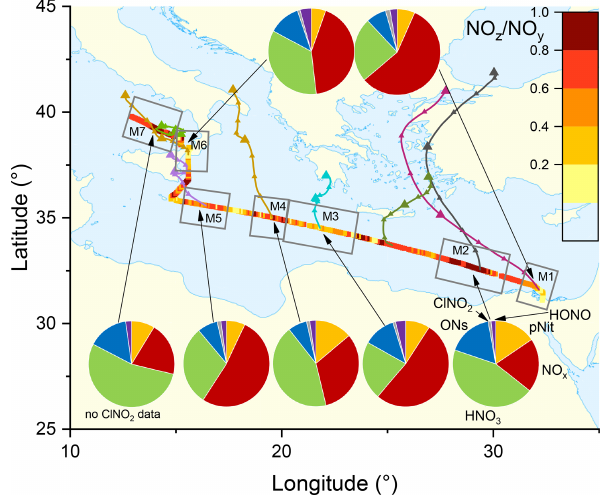
Figure 3. The NO z / NO y ratio over the Mediterranean Sea . Coloured lines are 2d back-trajectories (HYSPLIT). The pie charts indicate the components of NO y at various segments along the ship’s track (ONs = organic nitrates, pNit = particulate ni- trate). HNO 3 was calculated via HNO 3 = NO z – (ONs + pNit + ClNO + HONO). The colours of the pie chart segments are as- 2 signed as follows (clockwise): pNit in yellow, NO x in red, HNO 3 in green, ONs in blue, ClNO 2 in grey, and HONO in